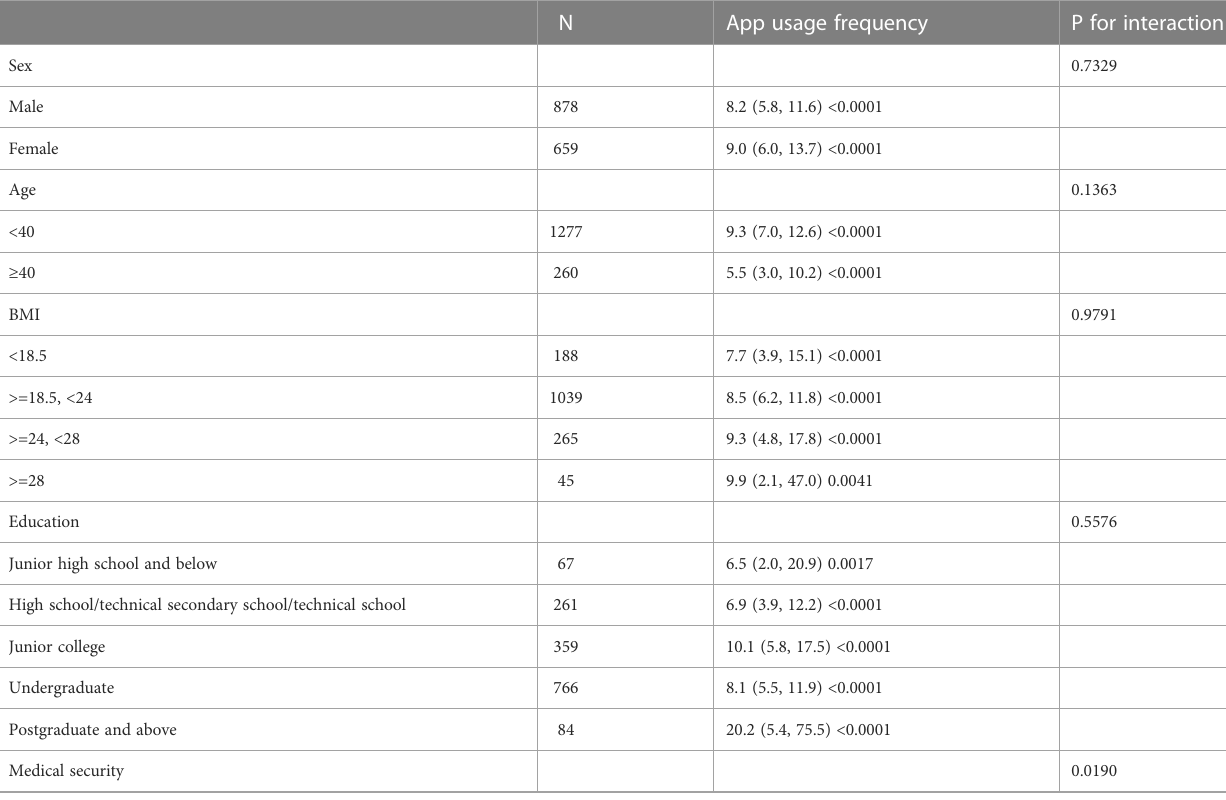
TABLE 5 (A) subgroup analysis of the correlation between online information exchange and app usage frequency.